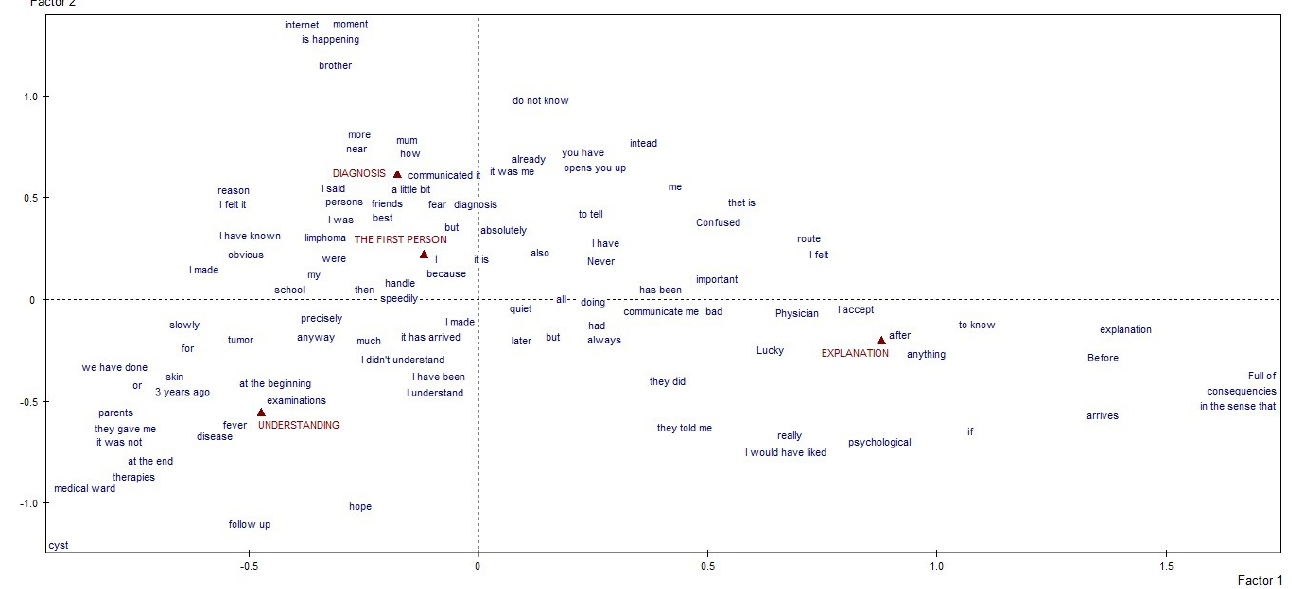
Figure 1. Graphic representation of the first outcome, about “the specifics of communications regarding the disease between patients and doctors”.